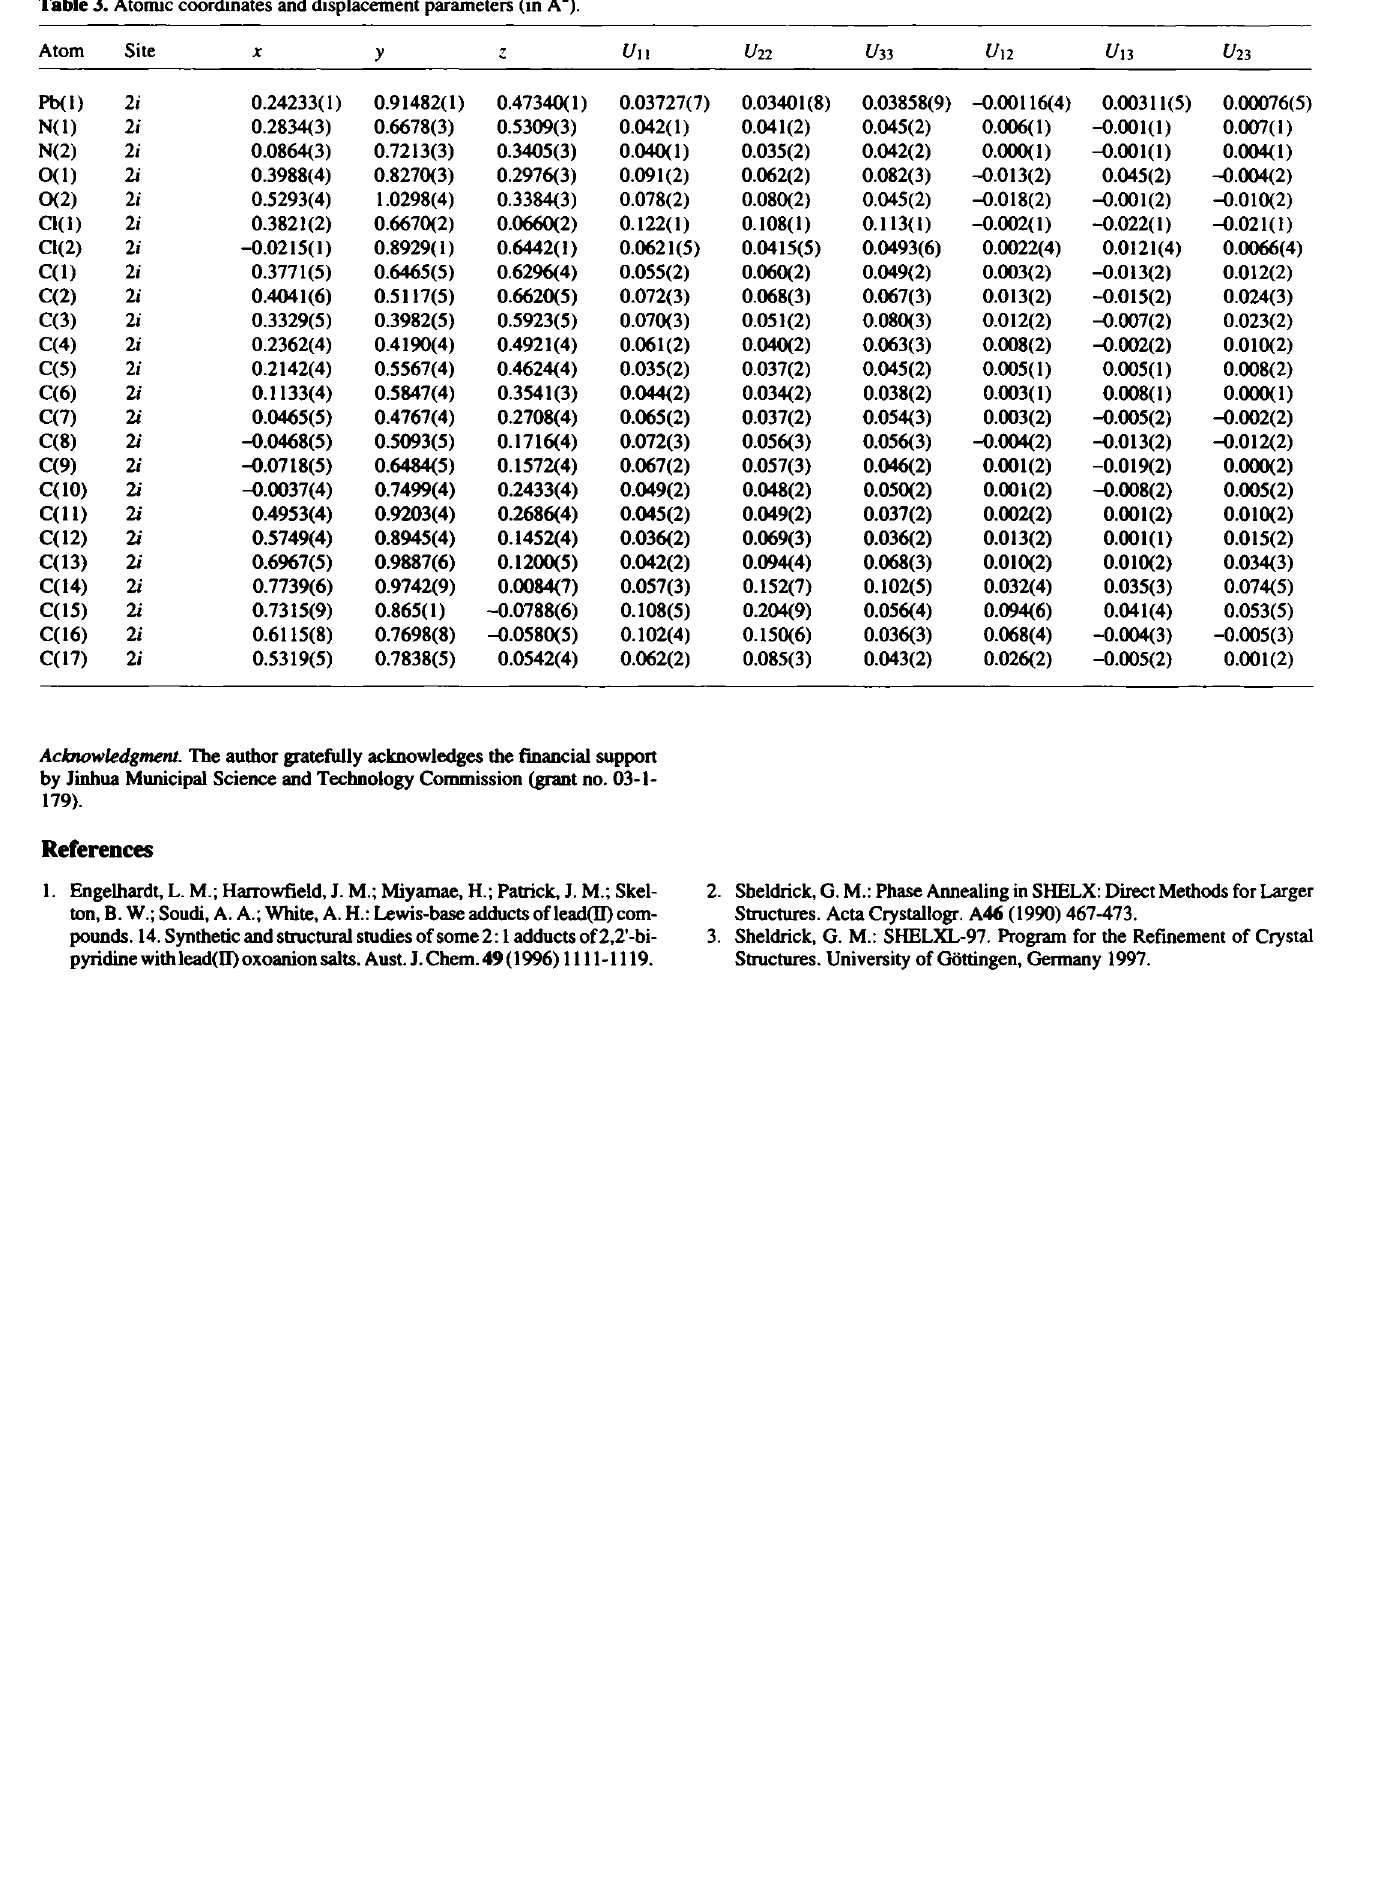
Table 3. Atomic coordinates and displacement parameters (in A 2